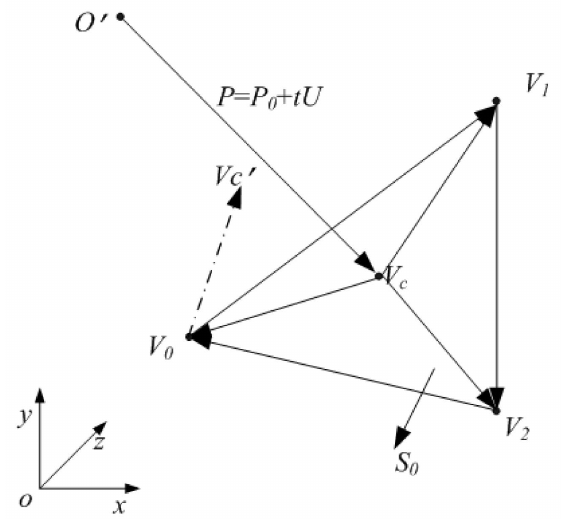
Figure 4. Schematic diagram of the intersection of the acoustic beam pipeline and triangular plane element.